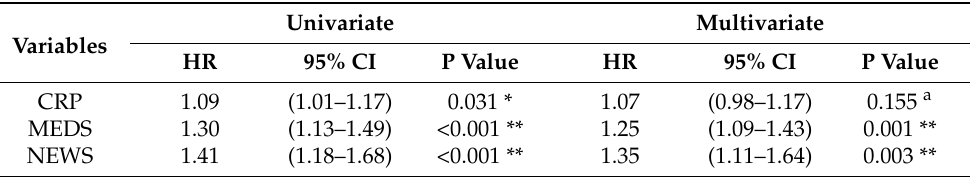
Table 3. Results of univariate and multivariate logistic regression analyses for predisposing factors on the clinical outcomes in patients of Listeria monocytogenes